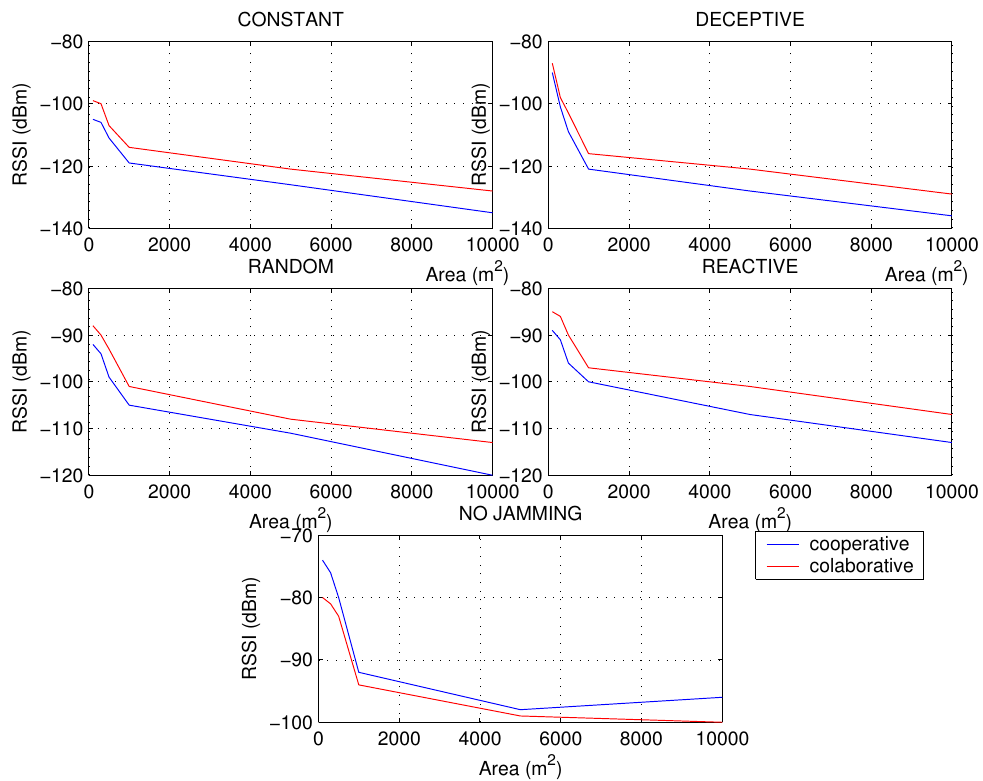
Figure 12. RSSI for types of jamming in a WSN of 200 nodes with different areas under collaborative and cooperative